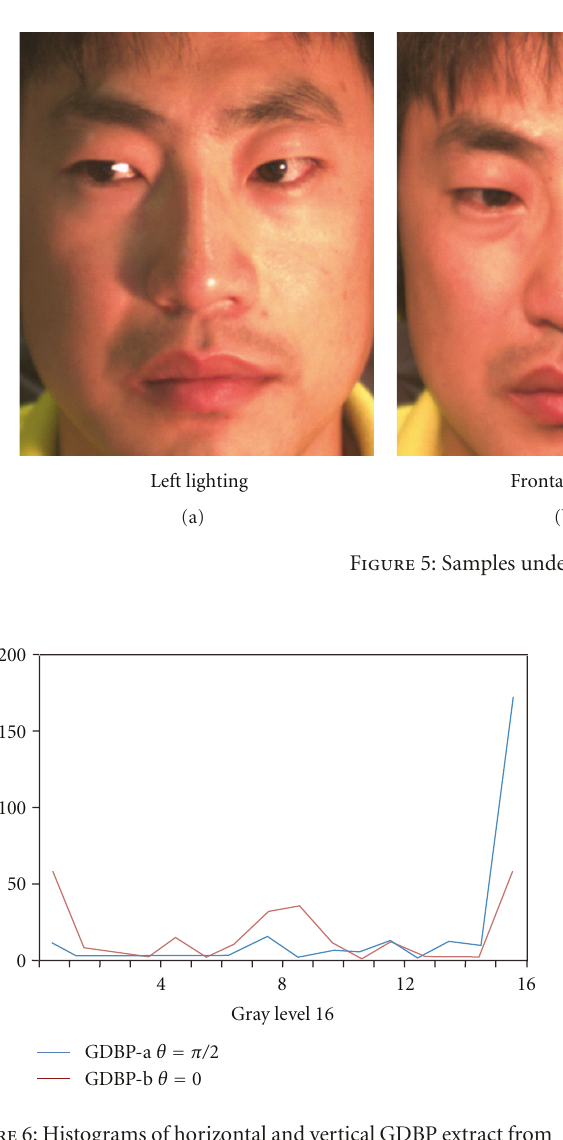
Figure 6: Histograms of horizontal and vertical GDBP extract from the white region image as shown in Figure 3(a).